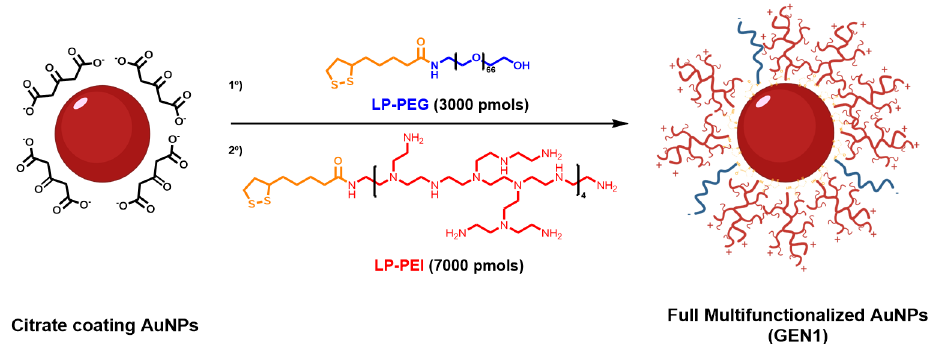
Figure 1. Synthesis scheme of the functionalization of citrate coating AuNPs with modified polyethyleneglycol (LP-PEG) and branched polyethylenimine (LP-bPEI).